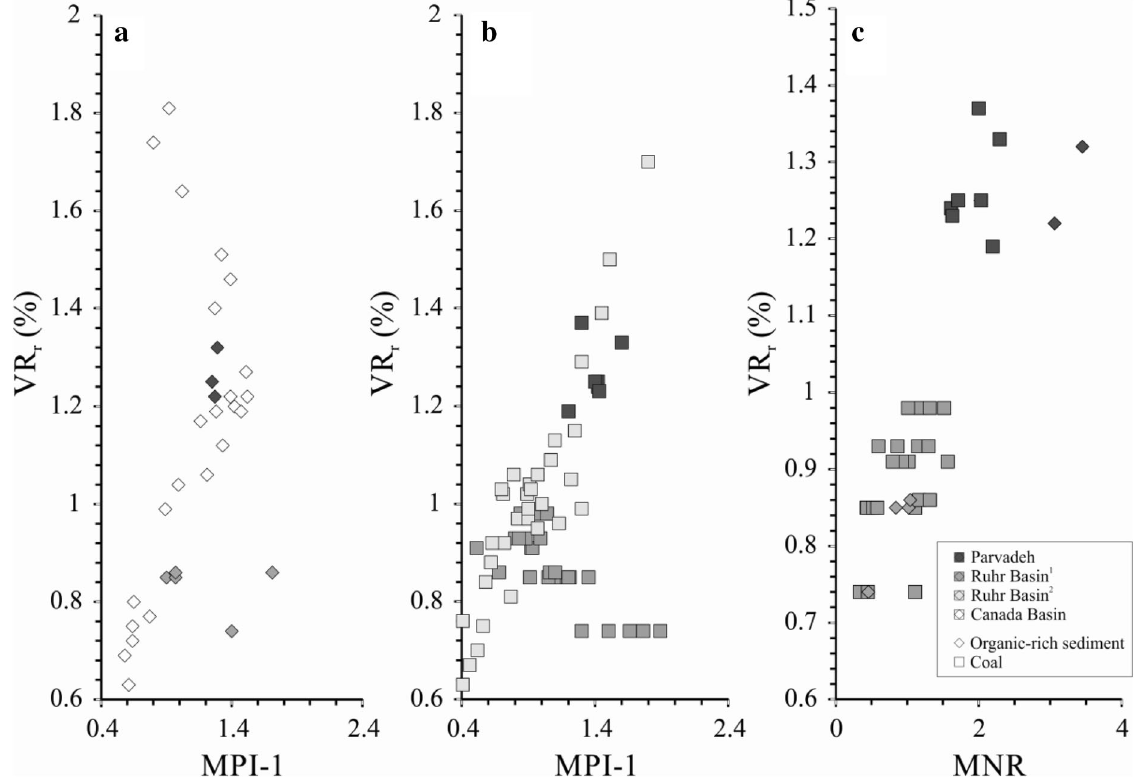
Fig. 7 Variation in MPI-1 values of the Parvadeh samples with maturity of: a organic-rich sediments in comparison to values reported for other basins (data from samples from the Ruhr 1 and Canada Basin from Bo¨cker et al. 2013; Radke et al. 1982a), b coals (data from the Ruhr Basin 2 from Radke et al. 1982b), c MNR values of the Parvadeh samples showing high